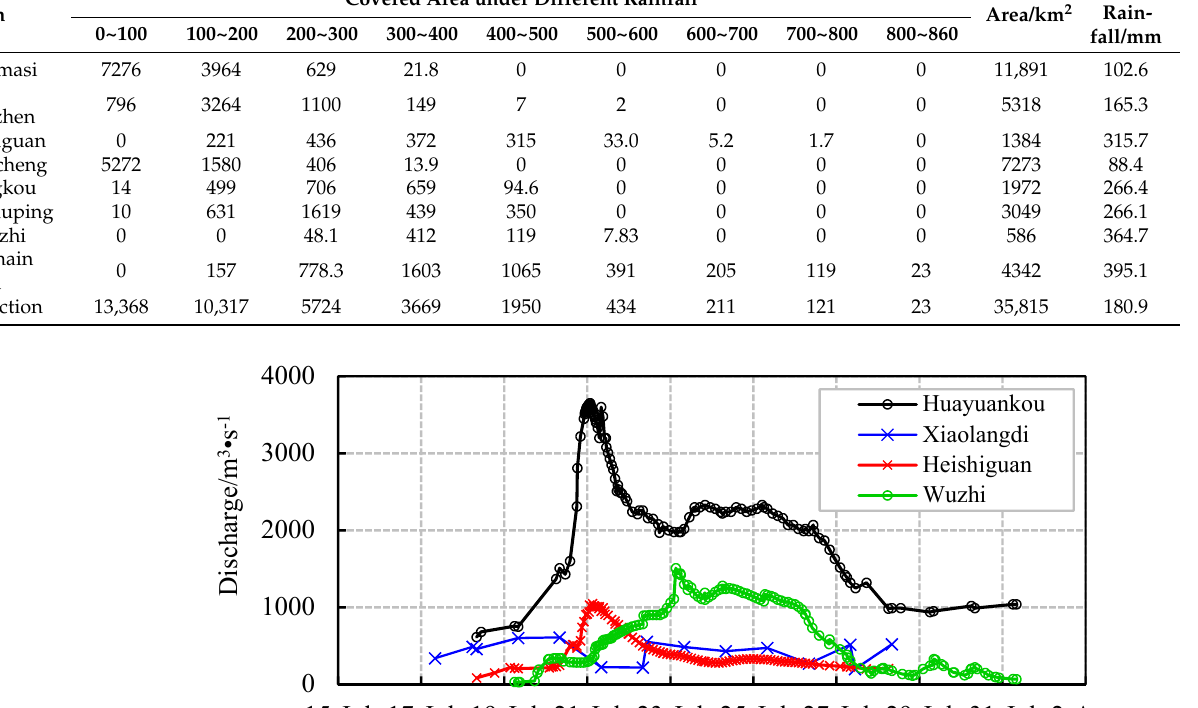
Figure 2. The runoff composition diagram of “7.21” flood at Huayuankou station.